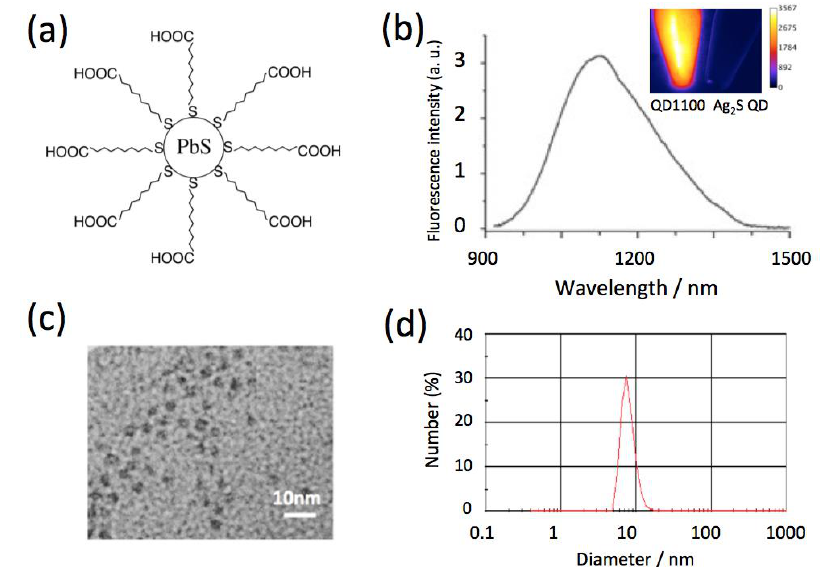
Figure 1. ( a ) Schematic structure of highly-fluorescent lead sulfide (PbS) quantum dots (QD) with emission peak at 1100 nm (QD1100). QD1100 is coated with mercaptoundecanoic acid to make it soluble in water; ( b ) Fluorescence spectrum of QD1100 in water. Inset: near-infrared (NIR) fluorescence image (>1000 nm) of QD1100. For comparison, fluorescence image (>1000 nm) of silver sulfide (Ag 2 S) QDs (emission maximum: 1250 nm) is also shown. Excitation: 785 nm; ( c ) TEM image of QD1100; ( d ) Hydrodynamic diameter of QD1100 in water, determined by dynamic light scattering.